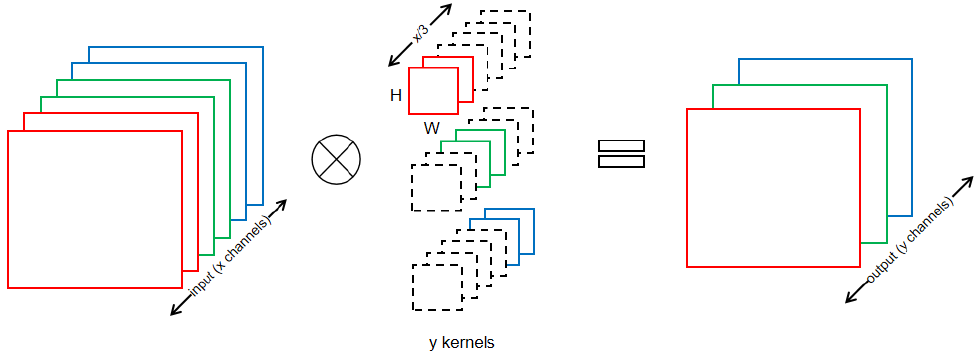
Figure 3. Group convolution (different colors represent different groups).